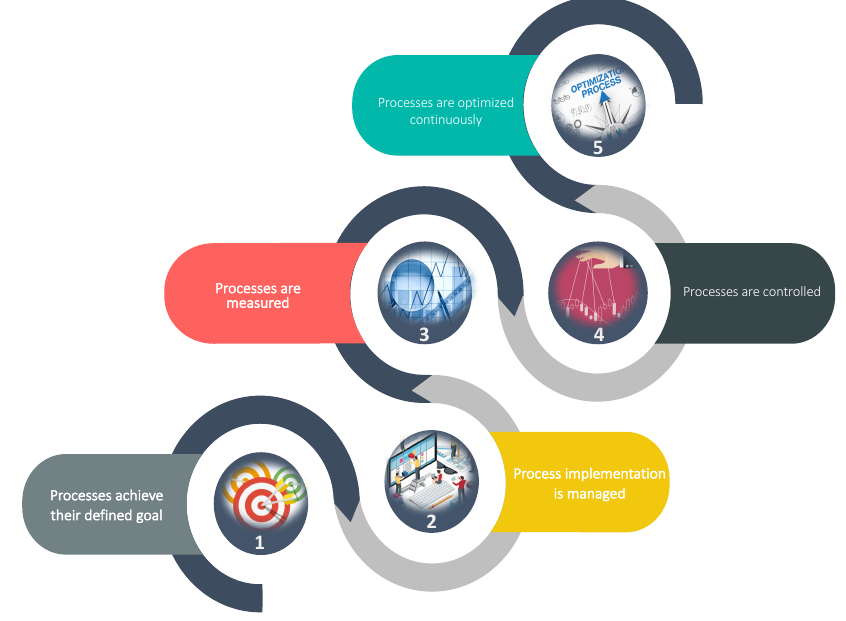
Figure 6. Maturity scale. Adapted from Silva and Cabral